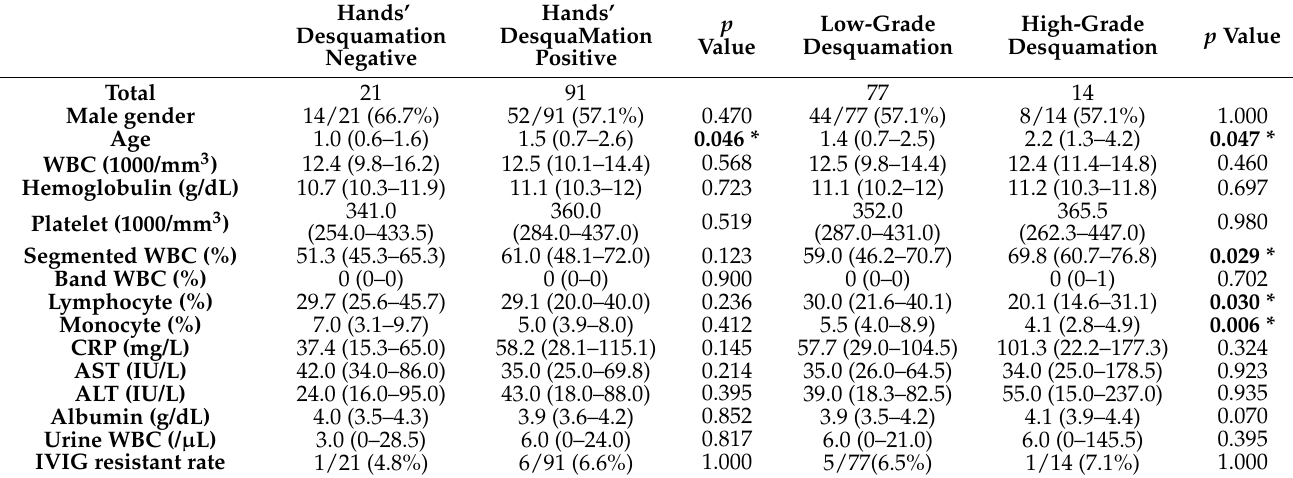
Table 2. Patients’ laboratory data of Kawasaki disease before IVIG (with hands’ desquamation positive or